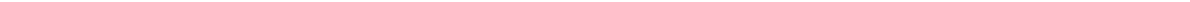
Fig. 5 Downstream effectors of CELF1. a Gene network identi fi ed by comparing HJAY, iTRAQ and RIP-Seq data, followed by manual curation to con fi rm gene function on the basis of literature search (see Supplementary Data 6 for additional detail). Protein interactions (light blue lines) were extracted from the STRING database. CELF1 direct interactors (RIP-Seq) are indicated in pink. Genes with deregulated protein and mRNA levels in CELF1-depleted melanoma cells, but not found bound to this RBP by RIP-Seq are labeled in gray. DEK regulated genes are marked with green borders. Bar charts refer to changes in RNA ( a , SK-Mel-103; b , UACC-62) and protein ( c , SK-Mel-103; d , UACC-62) levels in shCELF1-1 vs. shControl cells. b Representative micrographs of benign nevi and primary melanomas showing an elevated DEK protein expression (brown staining) during tumor progression. Nuclei were counterstained in blue with hematoxilin. c DEK mRNA expression levels of melanoma samples grouped by disease stage (data retrieved from TCGA database). d Overall survival of melanoma patients (shown in a Kaplan – Meier survival plot) with DEK levels above (high) or below (low) the